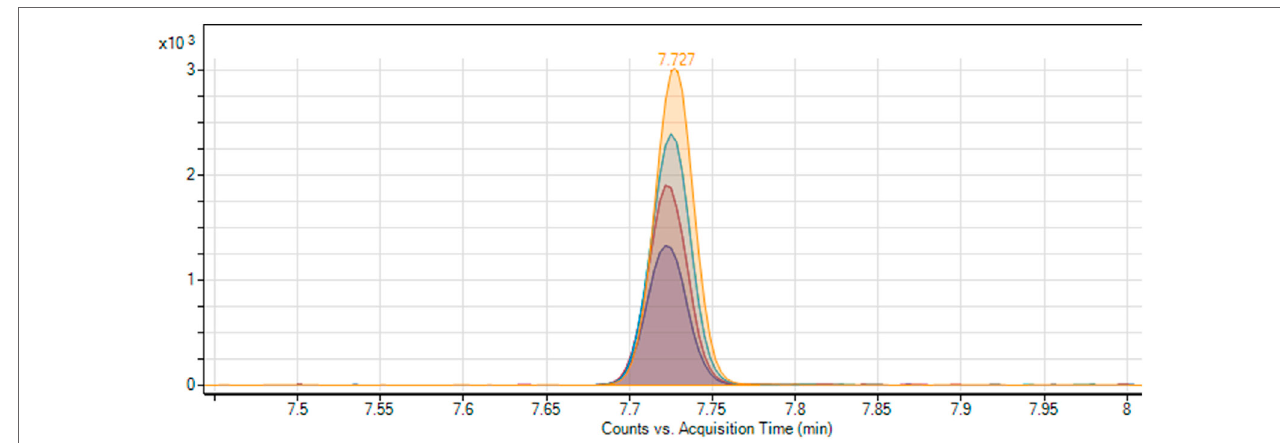
FigUre 5 | Overlapping chromatogram of standard addition method, which shows the gradual increase of the peak area of ethyl carbamate.